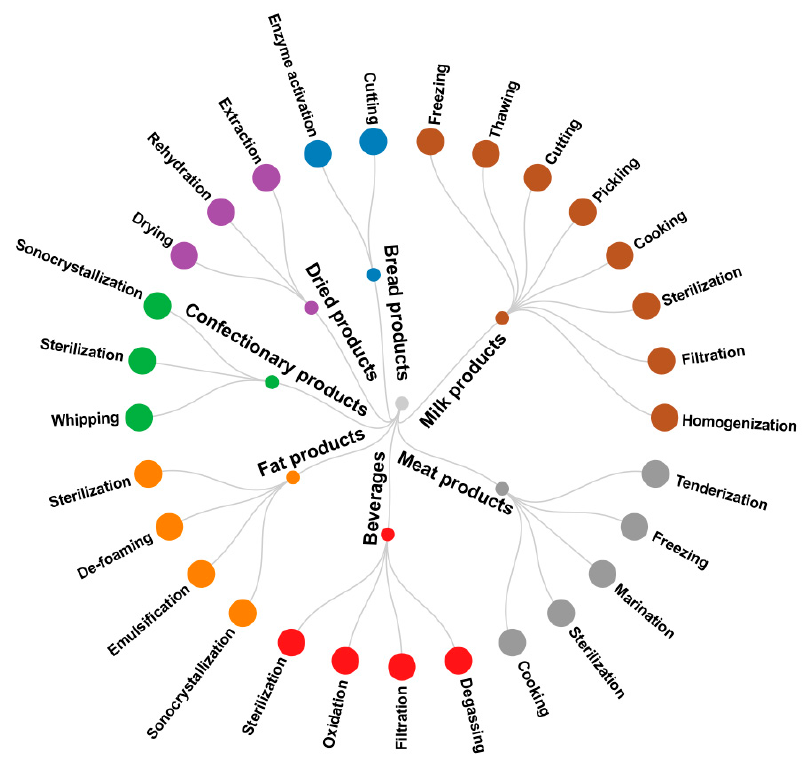
Figure 3. Application of ultrasonic treatment in various branches of the food industry.